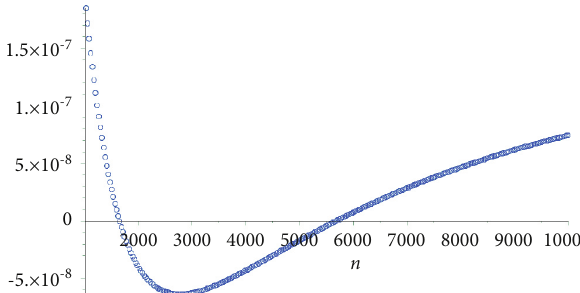
Figure 23: The relative error of F